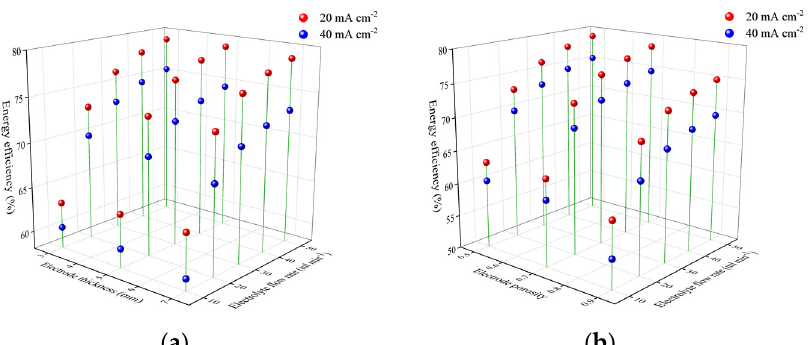
nesses and ( b ) di ff erent electrolyte fl ow rates and electrode porosities at a current density of thicknesses and ( b ) different electrolyte flow rates and electrode porosities at a current density of 40 mA cm (cid:2879)(cid:2870) . 40 mA cm − 2 .